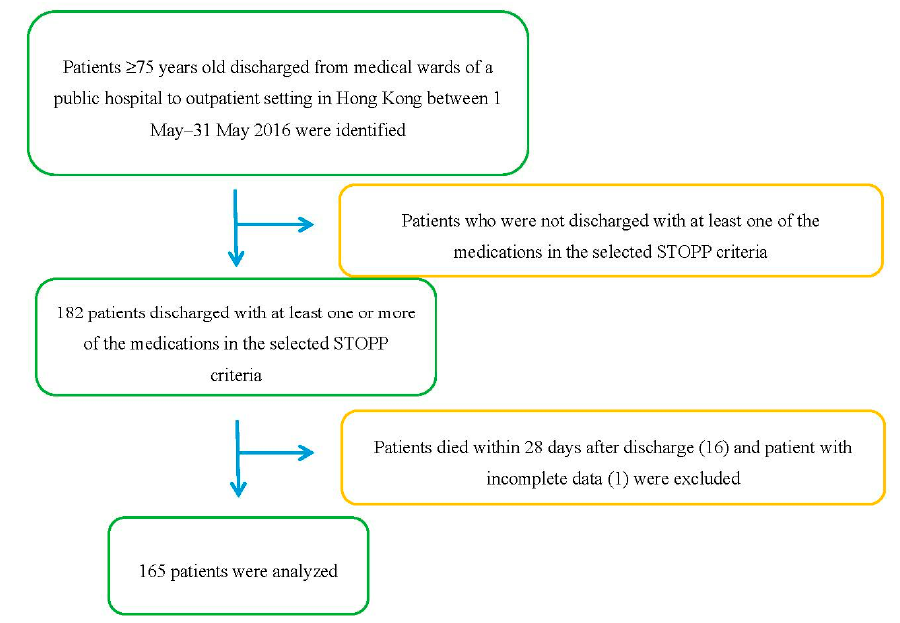
Figure 1. The process of patient selection. Table 1. Inclusion and exclusion criteria.